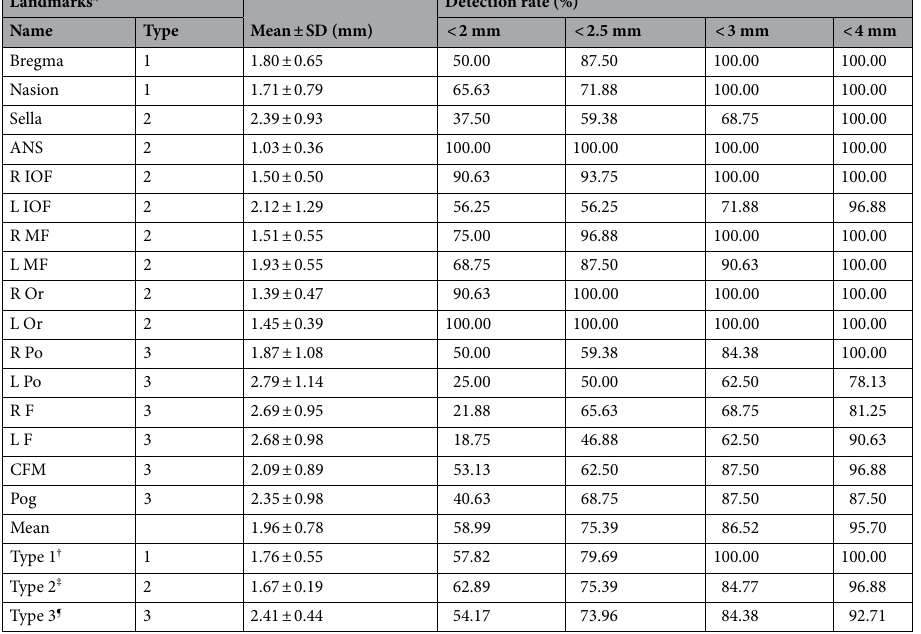
Table 1. Landmark detection rate and three-dimensional mean distance error by landmarks and their types. *For all landmarks: Kruskal–Wallis test, p < 0.001. † For all Type1 landmarks: Mann–Whitney test, p = 0.88. ‡ For all Type2 landmarks: Kruskal–Wallis test, p = 0.01. ¶For all Type3 landmarks: Kruskal–Wallis test, p = 0.56. For Type 1, 2 and 3 landmarks: two-way ANOVA, p = 0.87. For Type 1 and 3 landmarks: Mann–Whitney test, p = 0.02. For Type 2 and 3 landmarks: Mann–Whitney test, p < 0.0001. For Type 1 and 2 landmarks: Mann– Whitney test, p = 0.92. ANS anterior nasal spine, IOF infraorbital foramen, R right, L left, MF mental foramen, F mandibular foramen, CFM center of foramen magnum. Please refer to Supplementary Table 1 for their definitions and abbreviations.